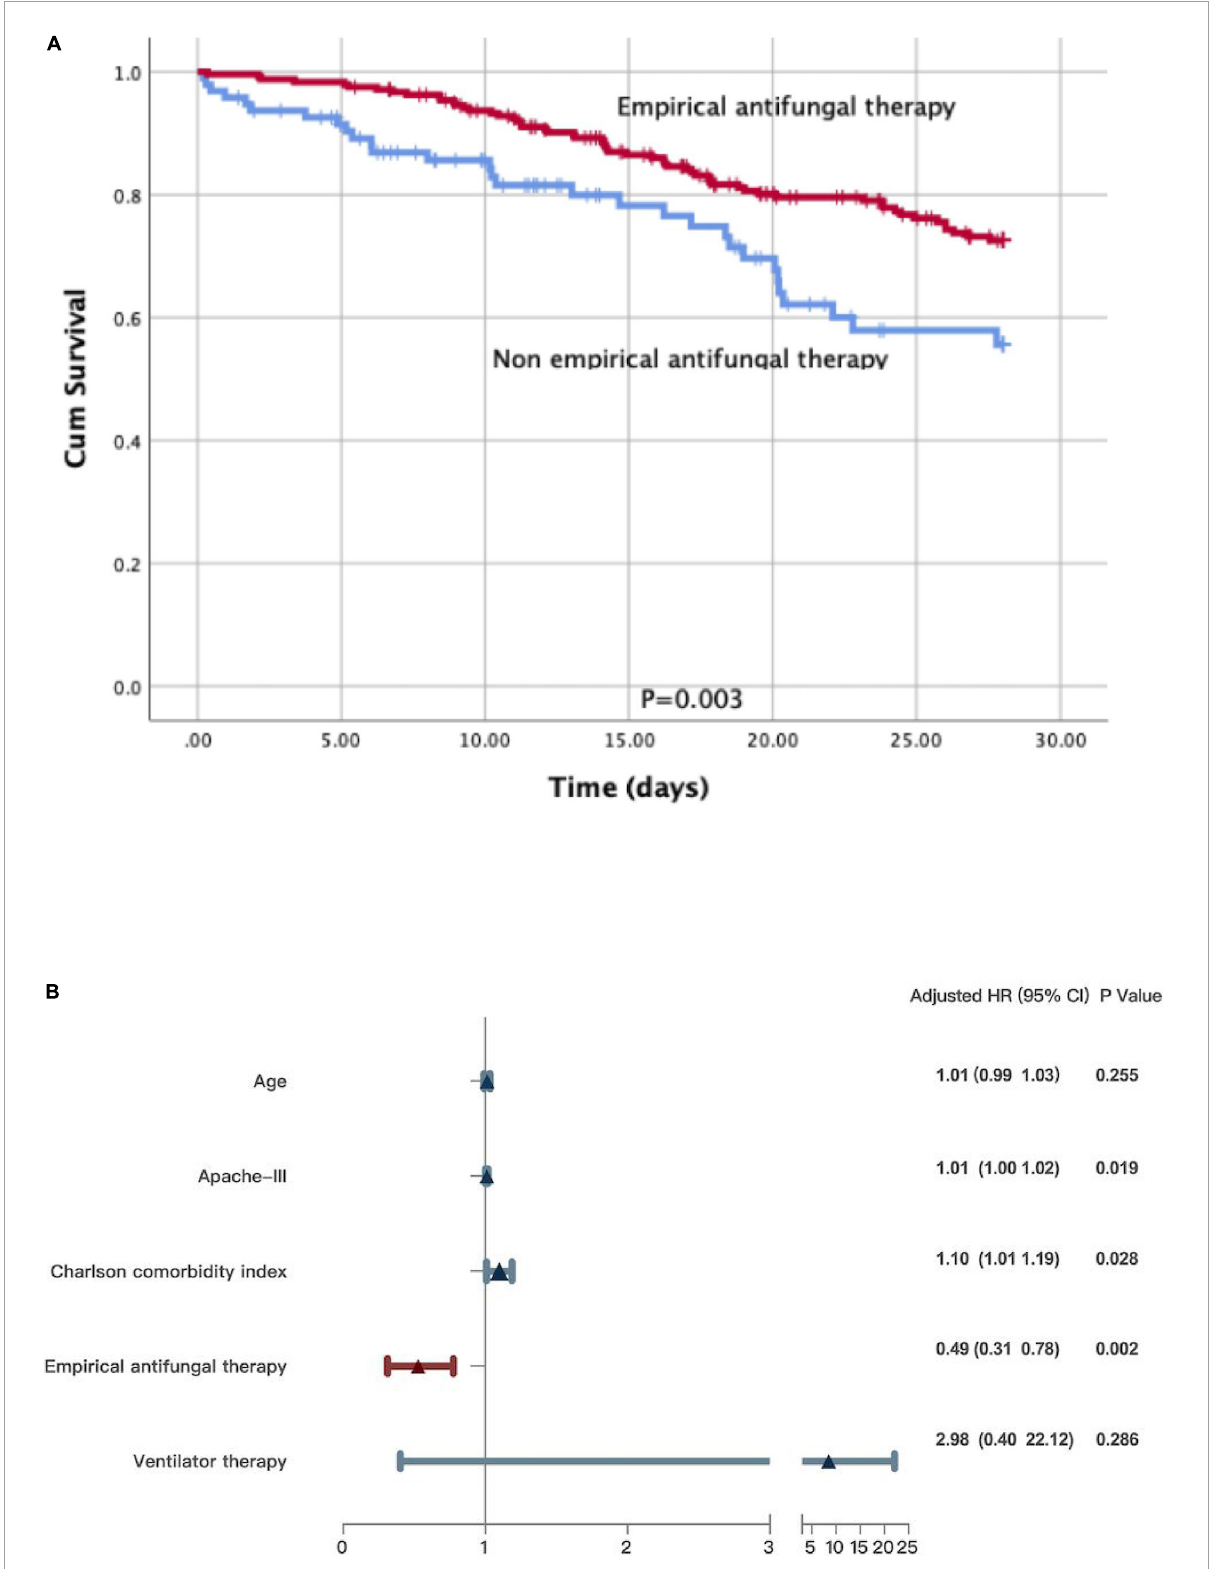
FIGURE3 (A) A Kaplan-Meier survival analysis and a log-rank test on patients with sepsis. (B) Multivariate Cox regression analyses for patients with